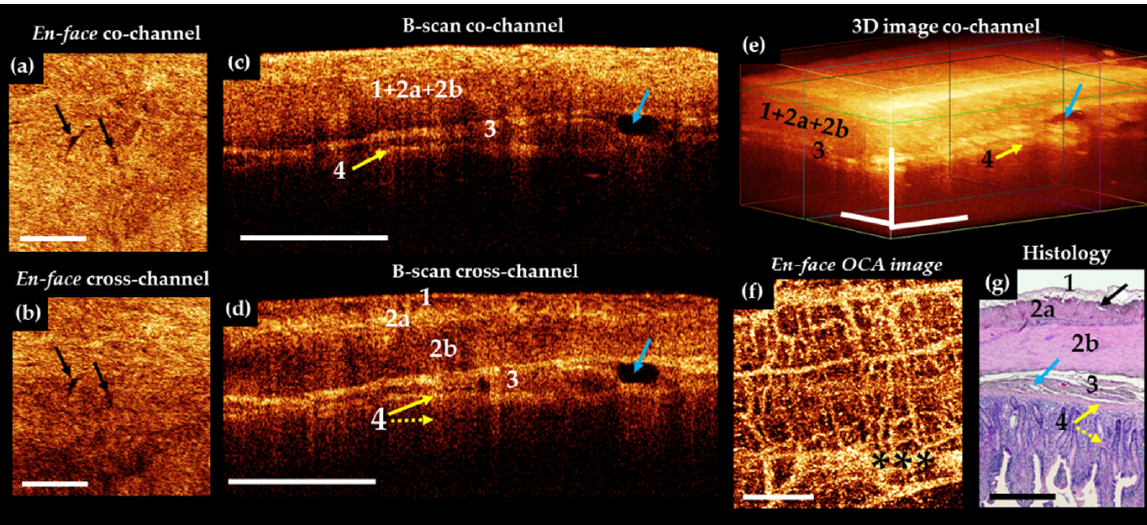
Figure 2. Representative trans-serosal MM OCT images ( a – f ) and corresponding histology ( g ) of normal small intestine of a pig. In the B-scans cross—channel ( d ) all 4 layers—serous membrane (1), muscularis externa (longitudinal muscular layer 2a and circular muscular layer 2b), submucosa (3) with blood and lymphatic vessels (blue arrows) and mucosa (4) (in particular, muscularis mucosa (yellow solid arrow) and adjacent to it the lamina propria (yellow dotted arrow)) are more clearly resolved, while in the co-channel not all anatomical layers are optically separated ( c ). ( a,b ) En-face OCT images at the level of the longitudinal muscular layer (green horizontal line in ( e )). Intermuscular spaces look like slits and there are few of them (black arrows). In the OCTA image ( f ), the network of blood vessels is dense and branched. Large and small blood vessels are visualized; the background of the image is light due to a dense network of a functioning capillary network. ( g ) Histological specimens stained with H&E. Asterisks in ( f ) indicate artefact of motion. Scale bars in CP OCT and OCTA images 1 mm, in histology 0.5 mm.